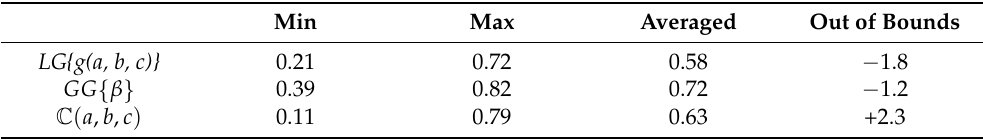
Table 4. Typical experimental values during